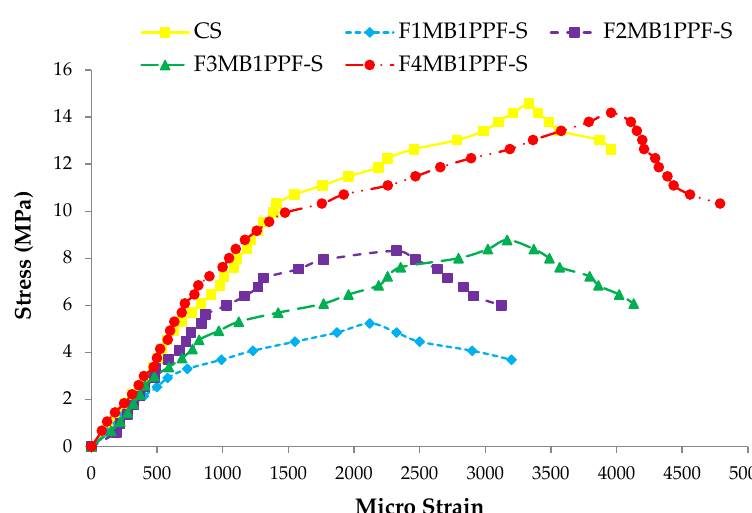
Figure 18. Comparison of flexure stress vs. strain of group A1 and CS slab.